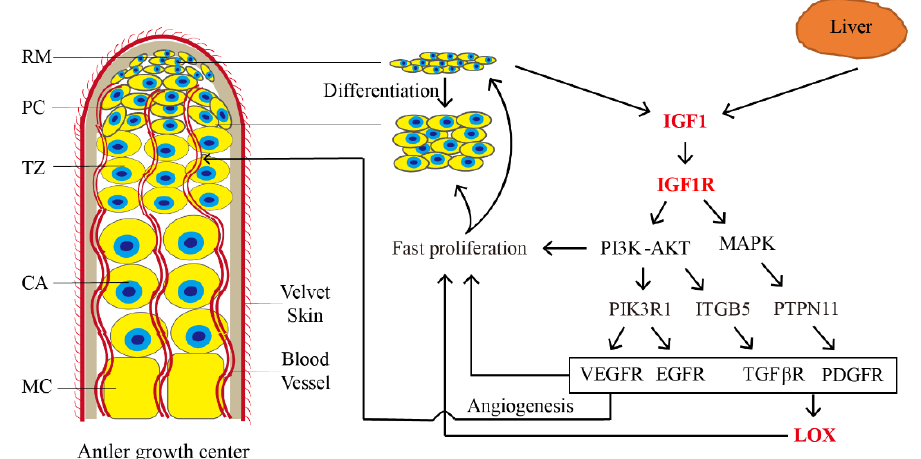
Figure 6. Gene regulation network of antler growth rate stimulated by IGF1/IGF1R . In the network, after activating IGF1/IGF1R , genes in PI3K/AKT and MAPK signaling pathways may be up-regulated, and expression of PIK3R1, ITGB5 and PTPN11 may promote VEGFR, EGFR, TGF ƥ R and PDGFR signal pathways to realize fast proliferation of RM cells. Genes in VEGFR signal pathways may also promote angiogenesis in antlers to ensure the nutrition supply for rapid growth. Activa- tion of genes in TGF ƥ R and PDGFR signal pathways may induce expression of LOX , which may mediate ECM remodeling, activate cell signaling and gene transcription and further promote rapid antler growth. RM, reserve mesenchyme; PC, pre-cartilage; TZ, transition; CA, cartilage; MC, min- eralized cartilage.